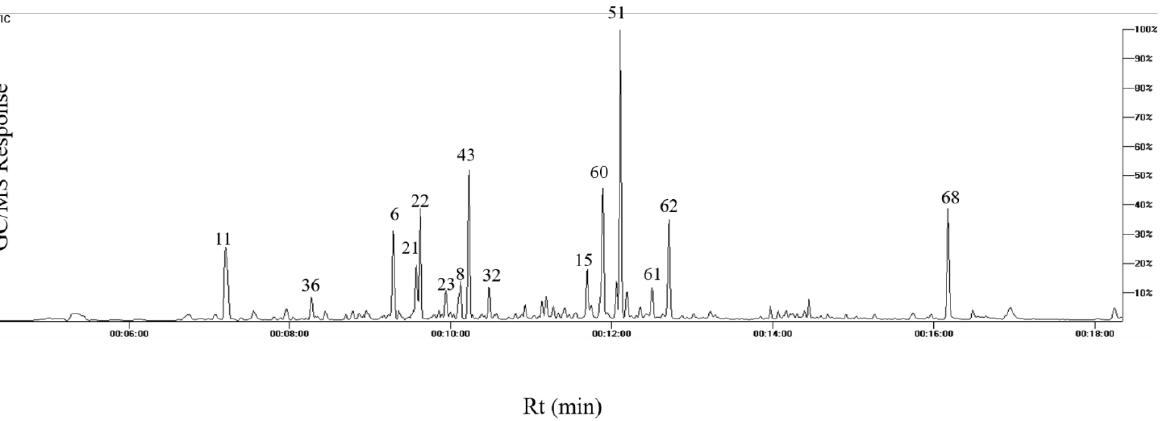
Figure 4. GC/MS chromatogram volatile metabolites in apricot fruits. The corresponding volatile names for each peak follow that listed in Table 3.